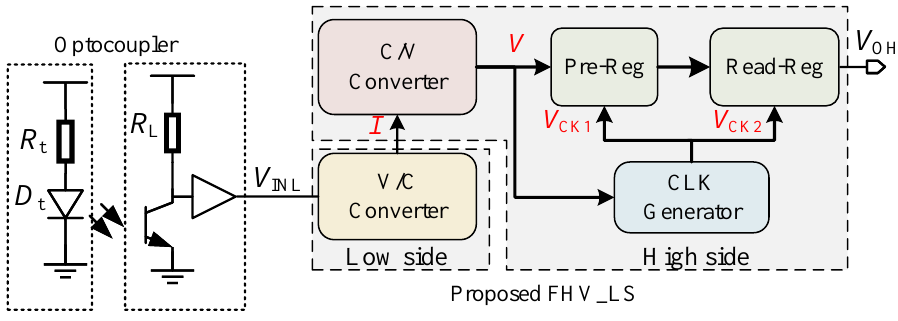
Figure 2. Topology of the proposed